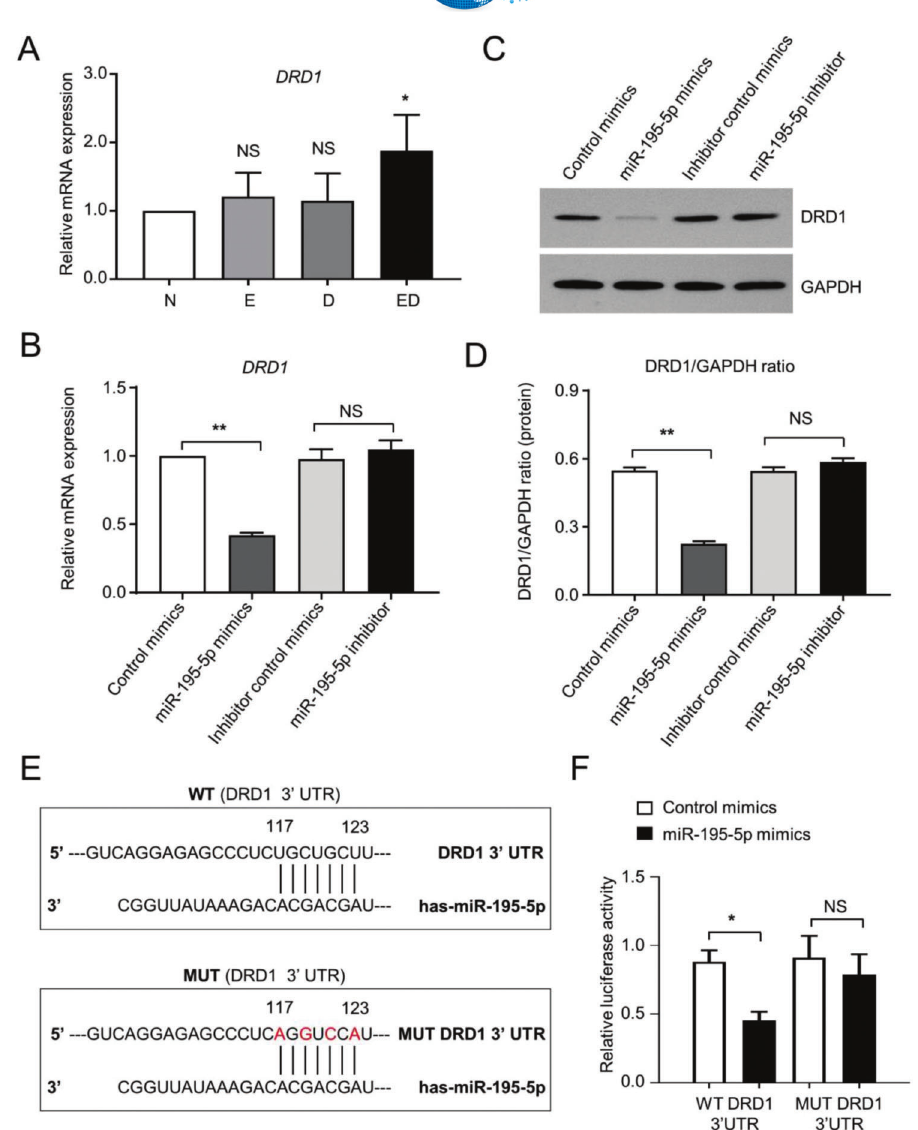
Figure 4 - DRD1 functions as the direct inhibitory target of miR-195-5p. A Validation of plasma levels of DRD1 by qRT-PCR. B Fold change of DRD1 mRNA expression in HEK-293T cells after transfection of miR-195-5p mimic or miR-195-5p inhibitor for 48h. Control mimics and inhibitor control mimics served as negative controls of miR-195-5p mimics and miR-195-5p inhibitors, respectively. C-D Expression levels of DRD1 proteins in the aforementioned four groups were quantified by western-blot assay ( C ), and gray-scale scanning with ImageJ software ( D ). GAPDH was used as an internal control. All data are shown as the mean ± SEM (n=3), * p o 0.05. E Putative wildtype (WT) and mutant type (MUT) sequences of miR-195-5p binding sites in the DRD1 3 0 UTR. F Luciferase reporter assay of the inhibitory activity of miR-195-5p upon transfection with DRD1 3 0 -UTR and DRD1-mut 3 ’ -UTR and/or miR-195-5p mimic or control mimic in in HEK-293T cells for 24h. All data are shown as the mean ± SEM (n=3), * p o 0.05; NS, not